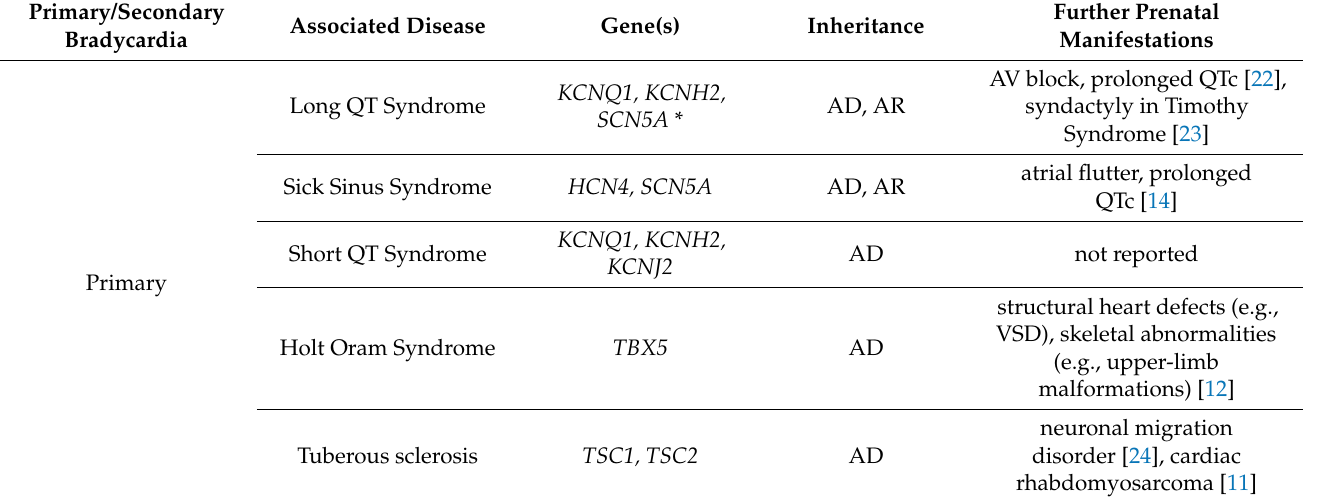
Table 2. Overview on monogenic diseases that can cause fetal